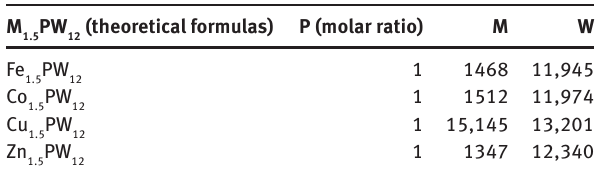
Table 1: Elemental analysis of the as-prepared unsupported heteropolyanion salt catalysts.